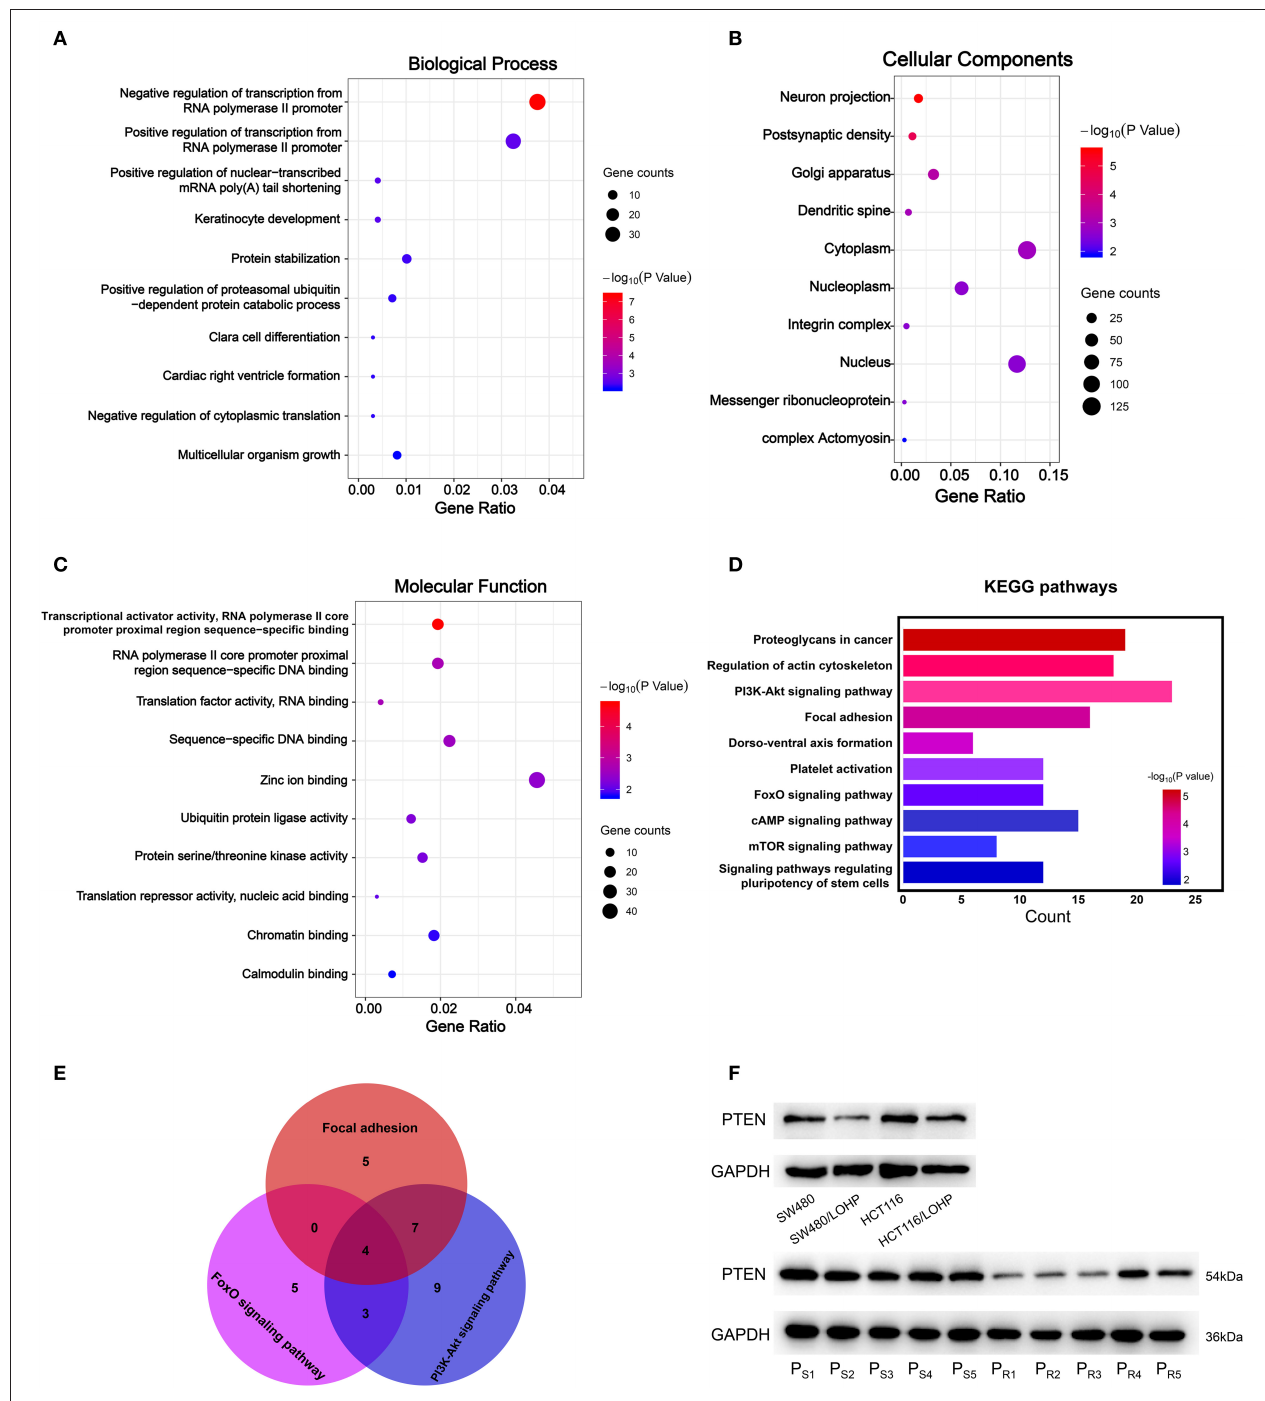
FIGURE 6 | GO and KEGG pathway analyses of downstream target genes of two upregulated miRNAs. (A-C) : GO analysis. (A) Biological processes. (B) Cellular component. (C) Molecular function. (D) The top ten KEGG pathways enriched in the target genes. (E) The analysis of Focal adhesion, FoxO signaling pathway, and PI3K-Akt signaling pathway. (F) The identified target gene PTEN was measured by Western blot in CRC cell lines and tissues. P S : chemosensitive CRC patients. P R : chemoresistant CRC